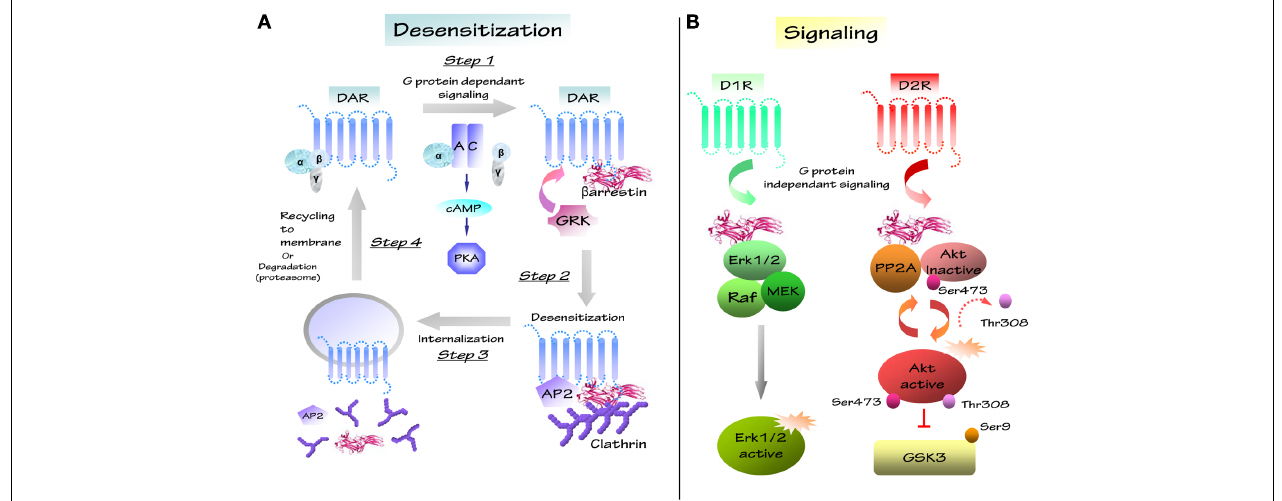
internalized in clathrin coated-pits and complex is disassembled (step3). Internalized GPCR is recycled to membrane or degradated by proteasome (step4). (B) D1 and D2 receptors can regulate several molecular pathways through different G protein-independent signalling. D1 receptor (D1R) may regulates protein complex composed of β arrestin 2/Erk/Raf/MEK and induces Erk activation. D2 receptor (D2R) modulates the Akt/ β arrestin 2/PP2A protein complex and the Akt downstream substrate GSK3 that is inhibited by